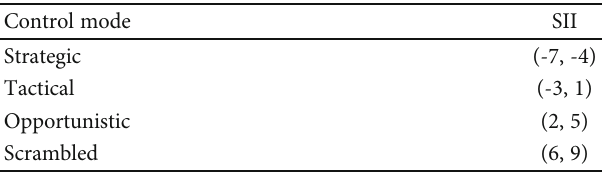
Figure 1: Control modes. Table 3: Relation between the SII and control mode.